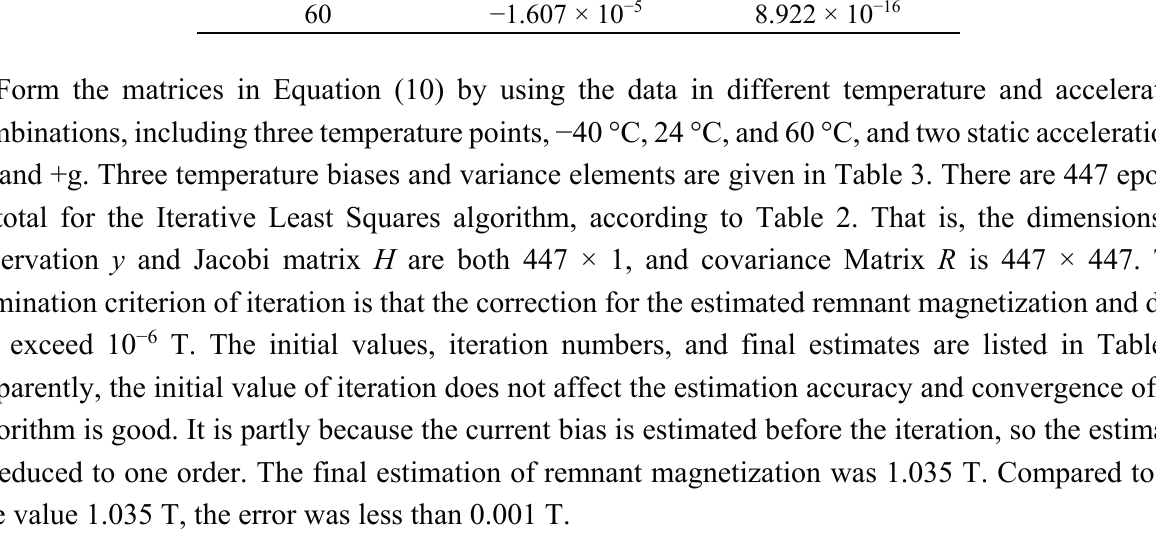
Table 4. The results of the Iterative Least Squares at different initial